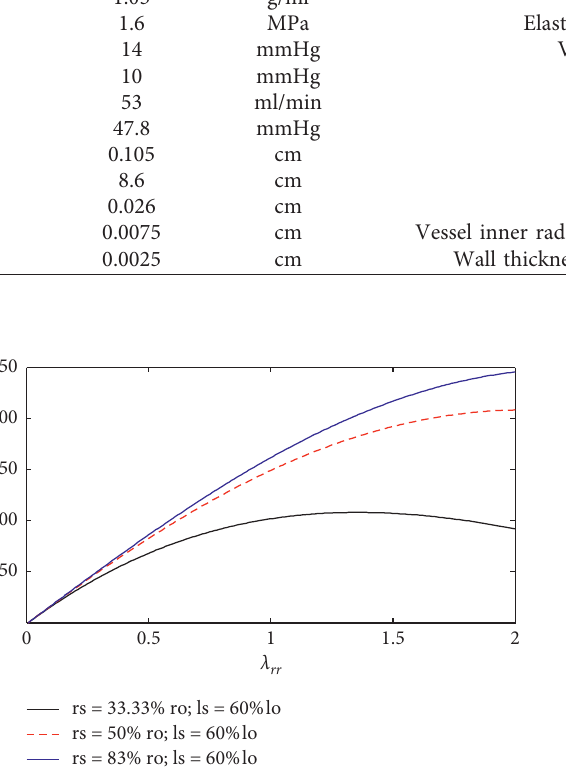
Figure 3: Study of the influence of stenosis on radial stress.